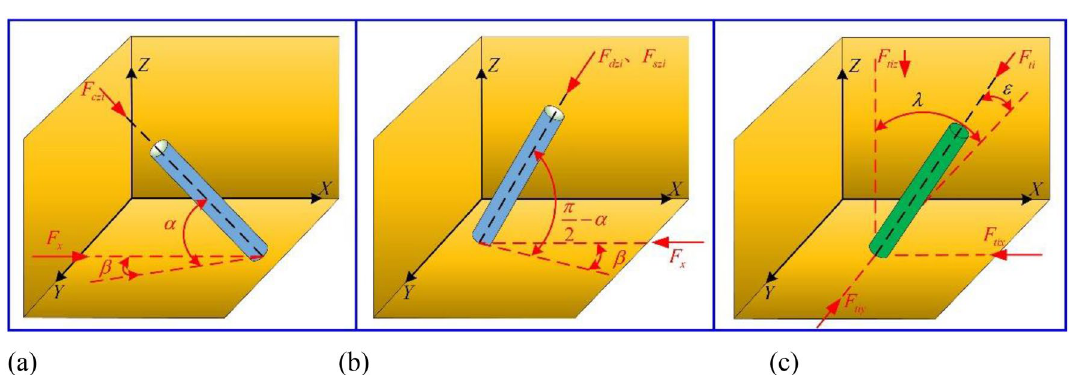
Figure 4. Diagram of relationship between drilling reaction force, leg supporting force and coordinate axis angle: ( a ) relationship between side wall drilling reaction and dip angle; ( b ) relation between top drilling reaction and dip angle; ( c ) schematic diagram of leg reaction and